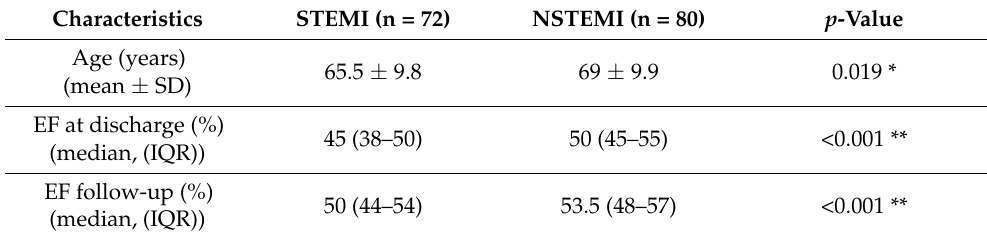
Table 7. Differences between STEMI and NSTEMI